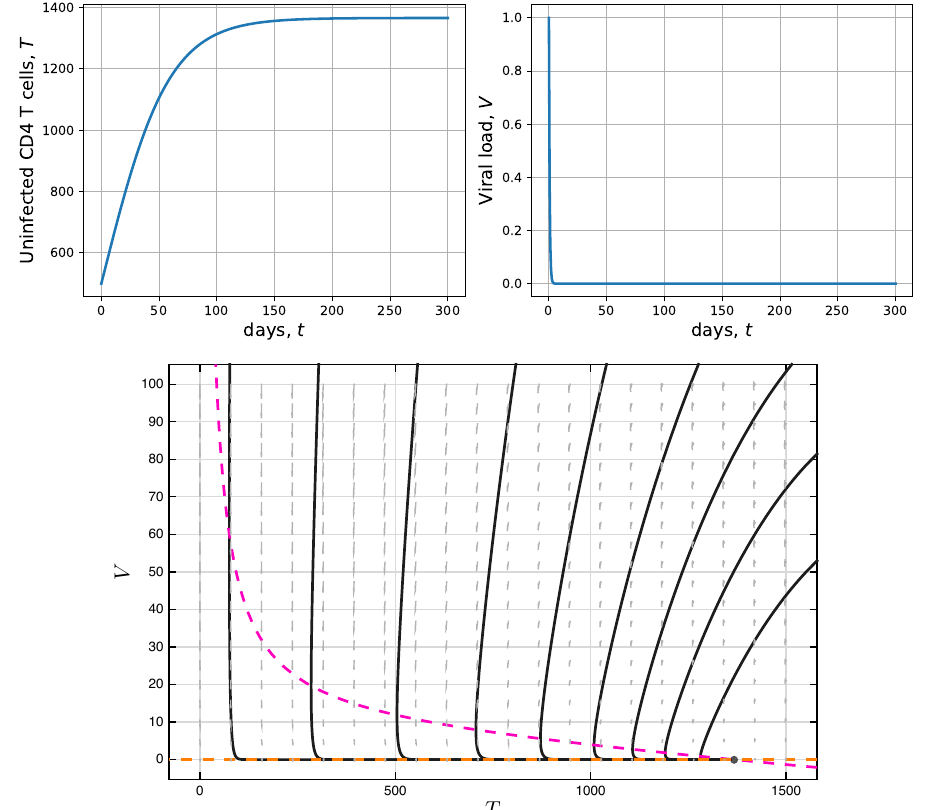
Figure 1. Numeric solutions vs. time ( top panels ) and phase space ( bottom panel ), corresponding to uninfected CD4 T-cells and viral load in model (1), with β = 6 × 10 − 6 and R 0 = 0.8953 are shown. In this scenario the virus-free equilibrium E 0 is locally asymptotically